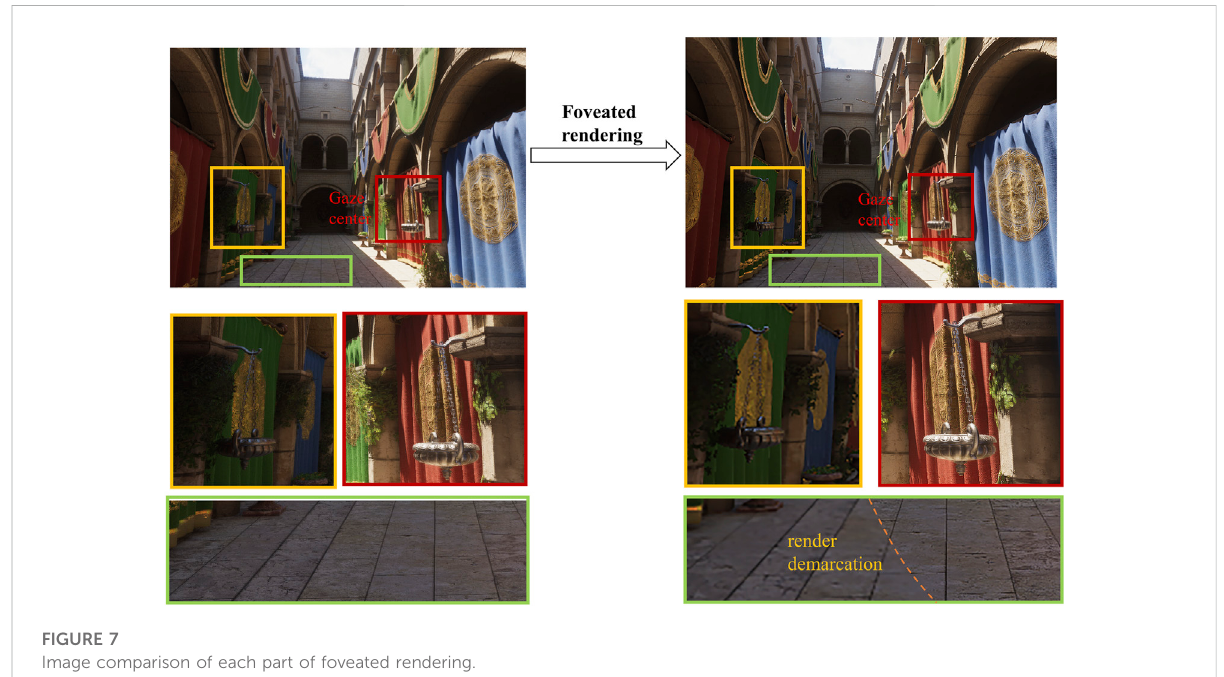
FIGURE 7 Image comparison of each part of foveated rendering.